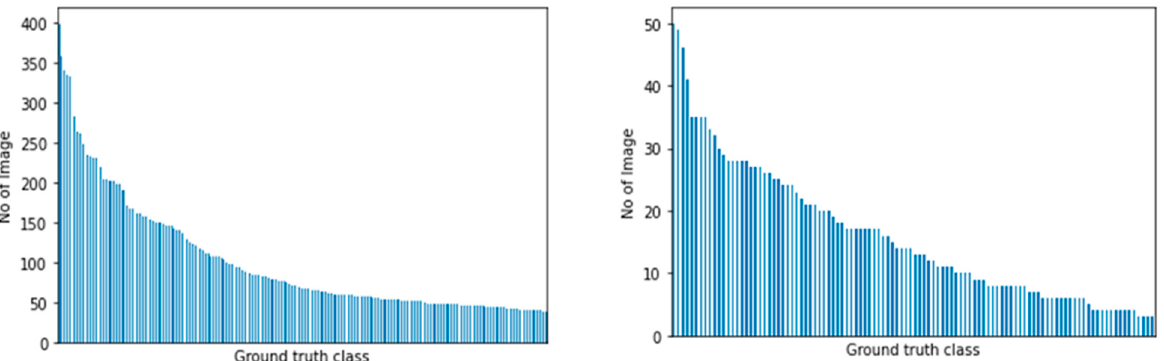
Figure 3. Class distribution for PlantCLEF 2015 ( left ) and UBD Botanical dataset ( right ). Ground truth class names were removed from the x -axis for brevity.